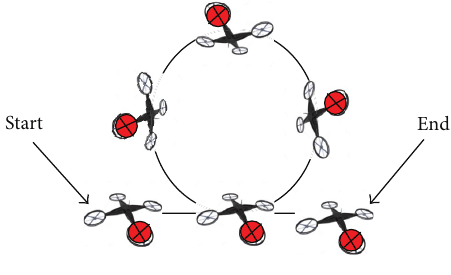
Figure 1: Looping